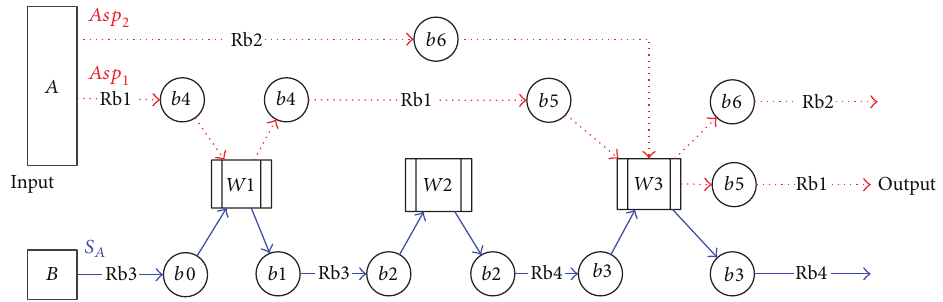
Figure 1: Default working process diagram of